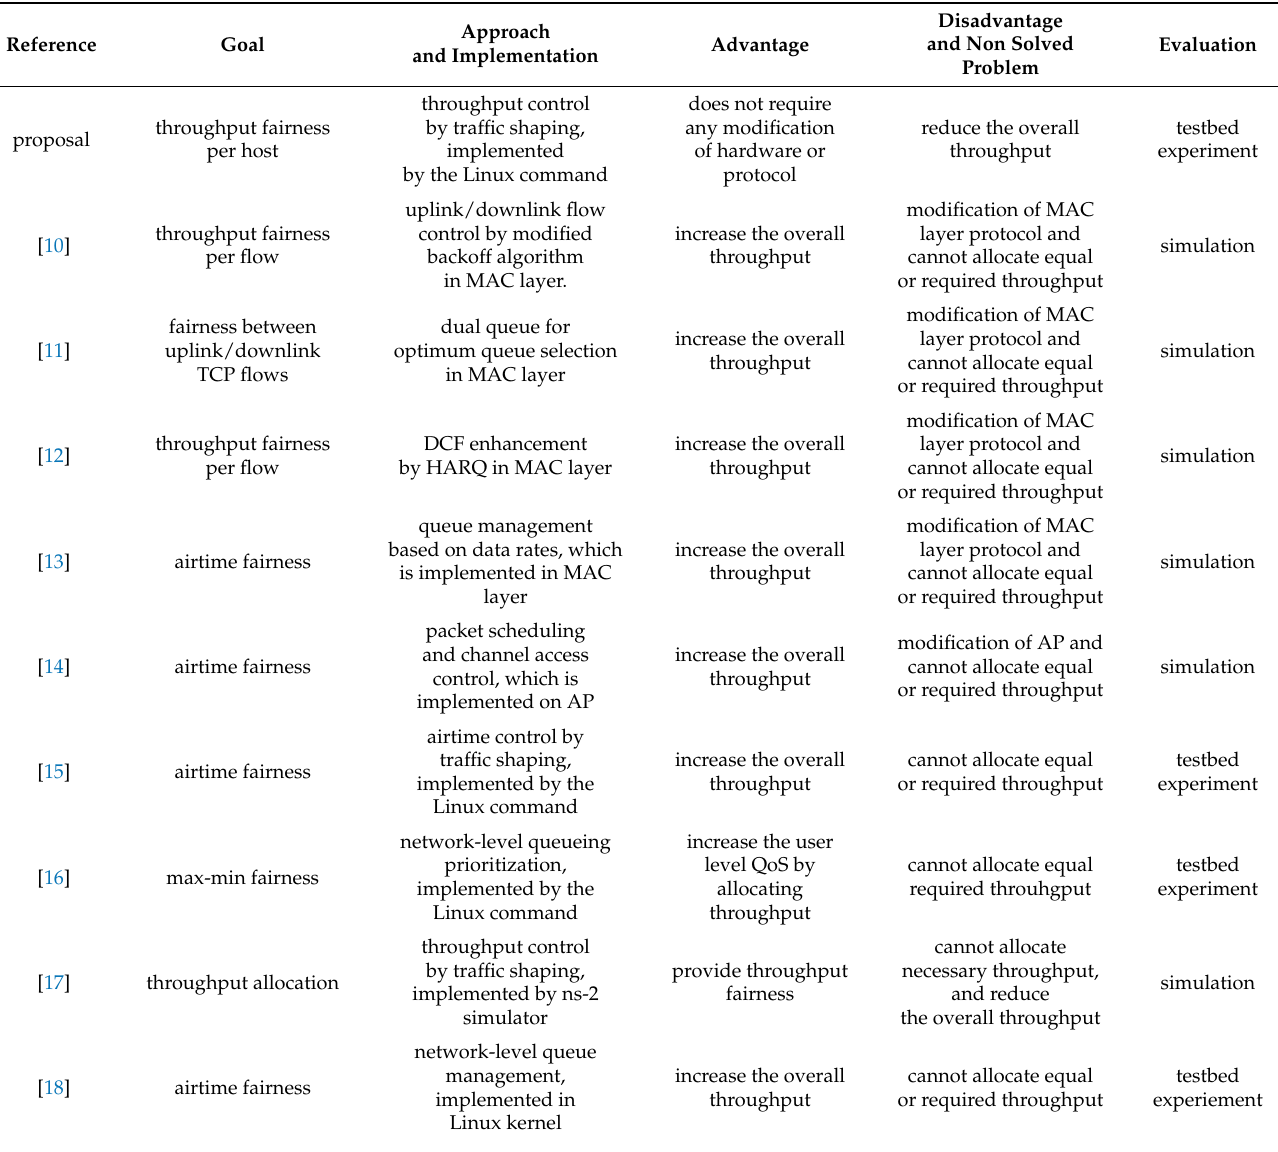
Table 1. Overview of related